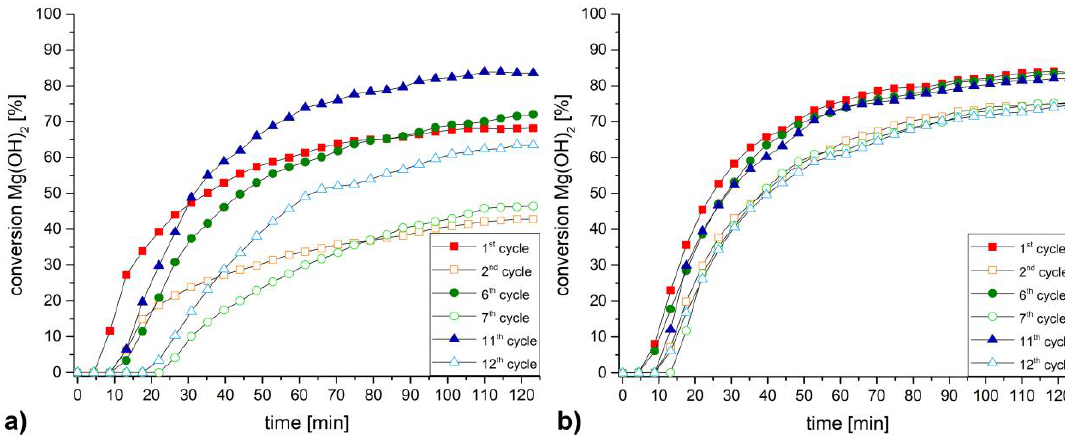
Figure 8. Selected conversion rates from a series of 15 consecutive calcination – hydration cycles, including two regeneration steps in liquid water after the 5th and the 10th cycle. ( a ) Mg(OH) 2 - originating MgO after regeneration; ( b ) MgCO 3 -originating MgO after